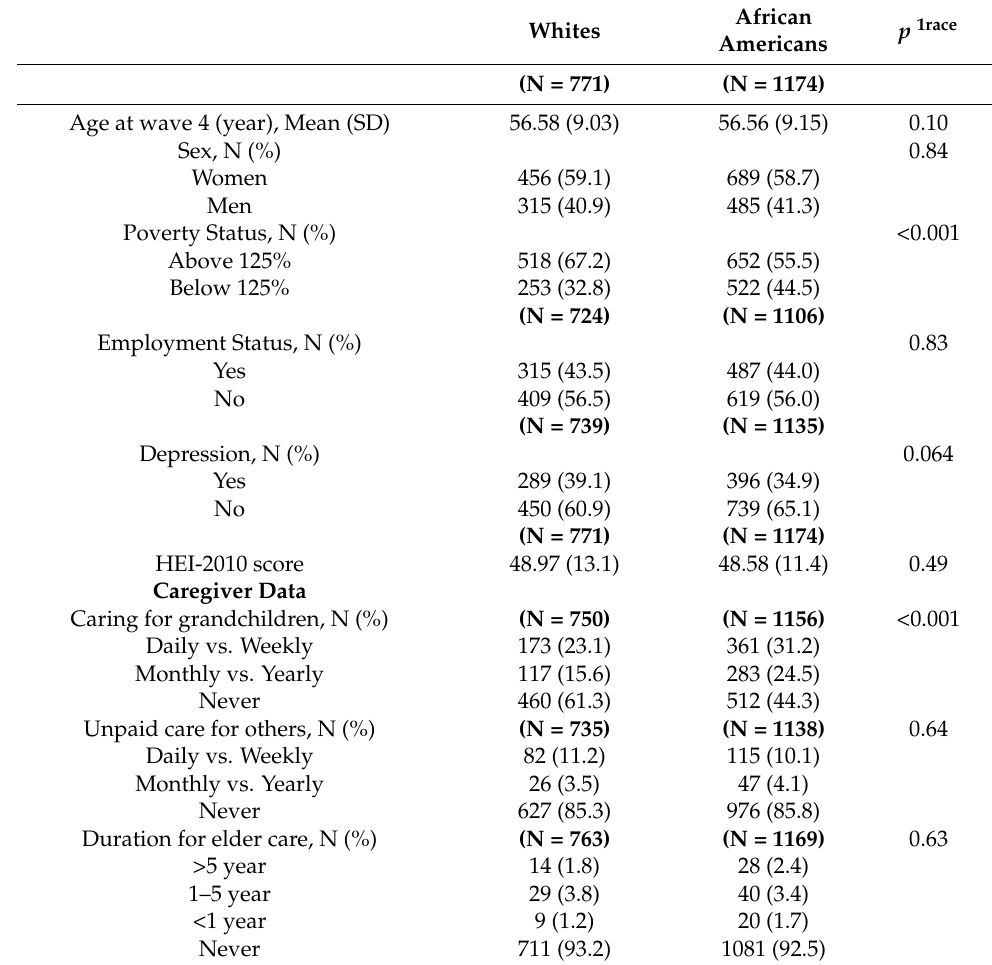
Table 2. Characteristics of HANDLS participants at wave 4 (N =